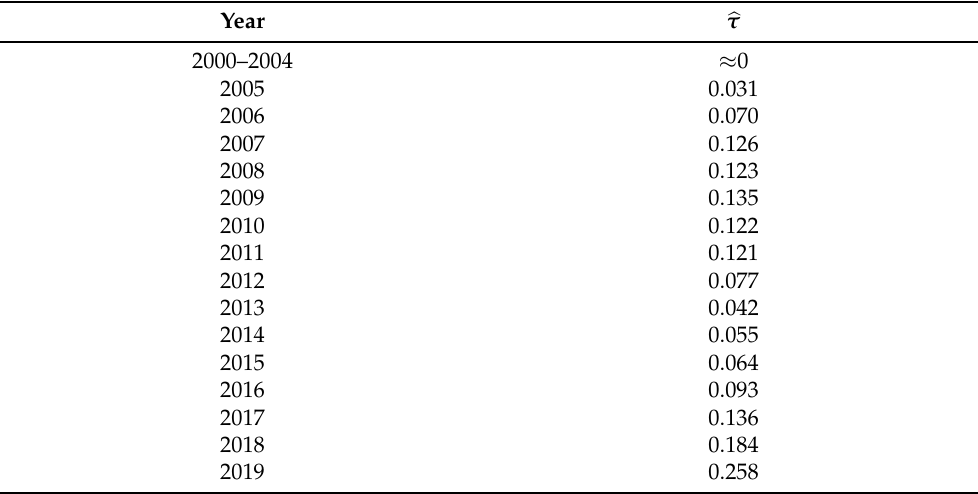
Table 2. Estimated value of τ for the different years, t ,